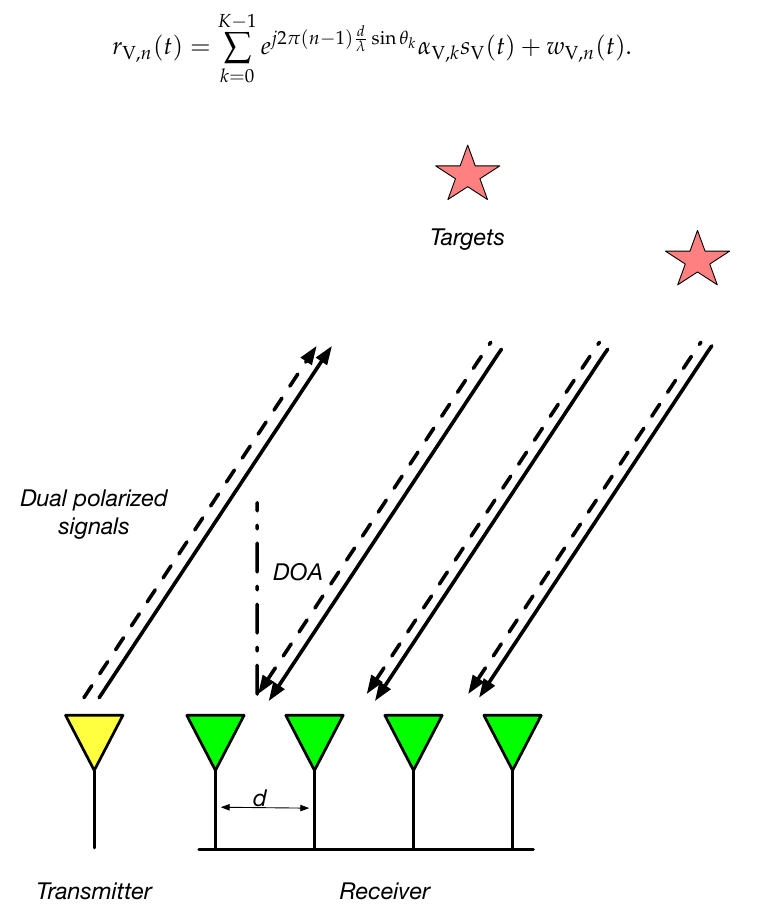
Figure 1. The dual-polarized radar